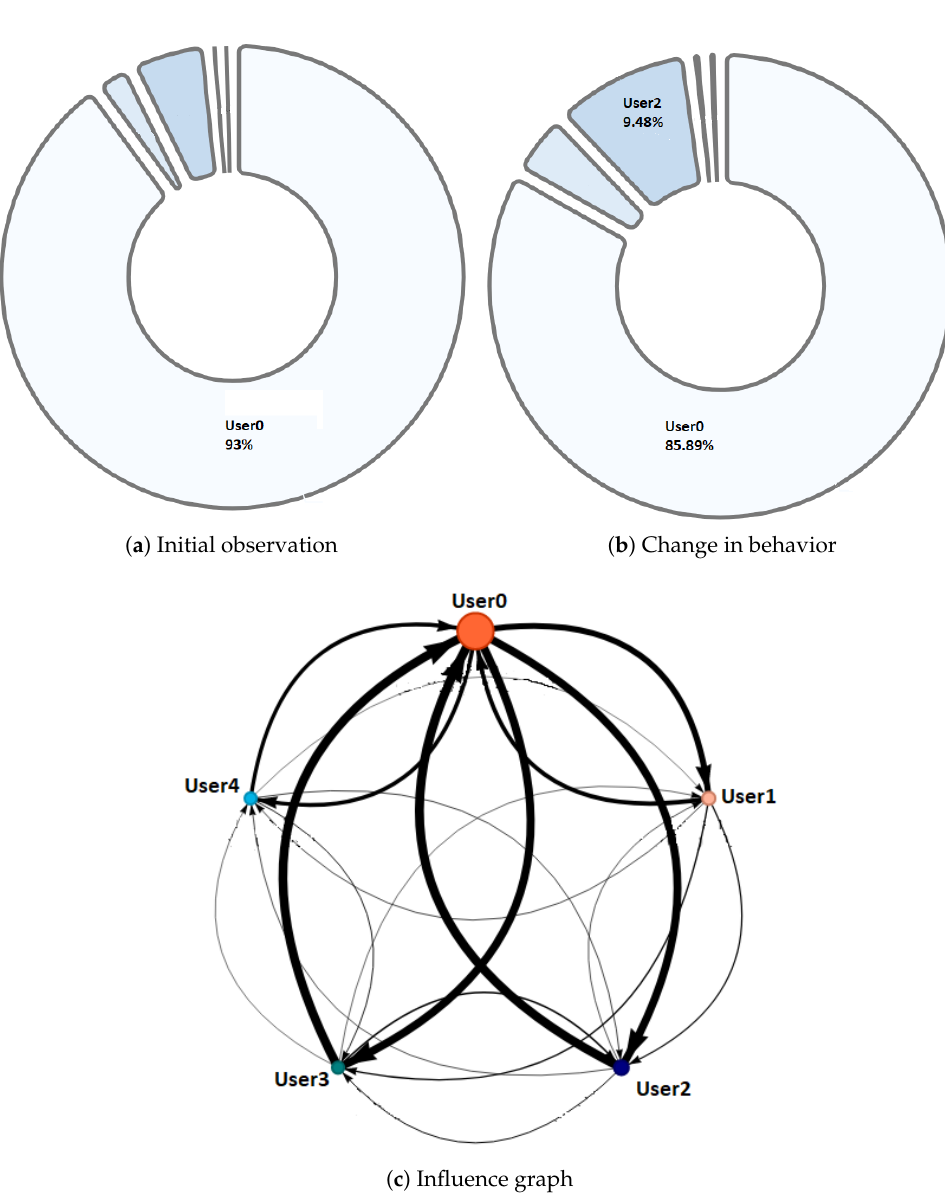
Figure 9. Behavior observed in G3 during phase